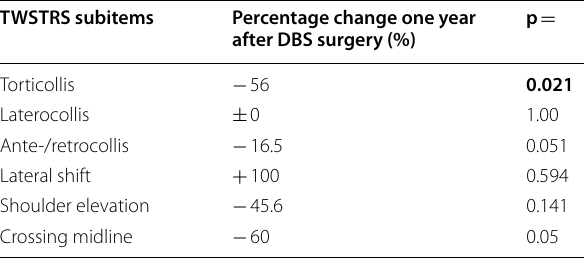
Significant results in bold at p <